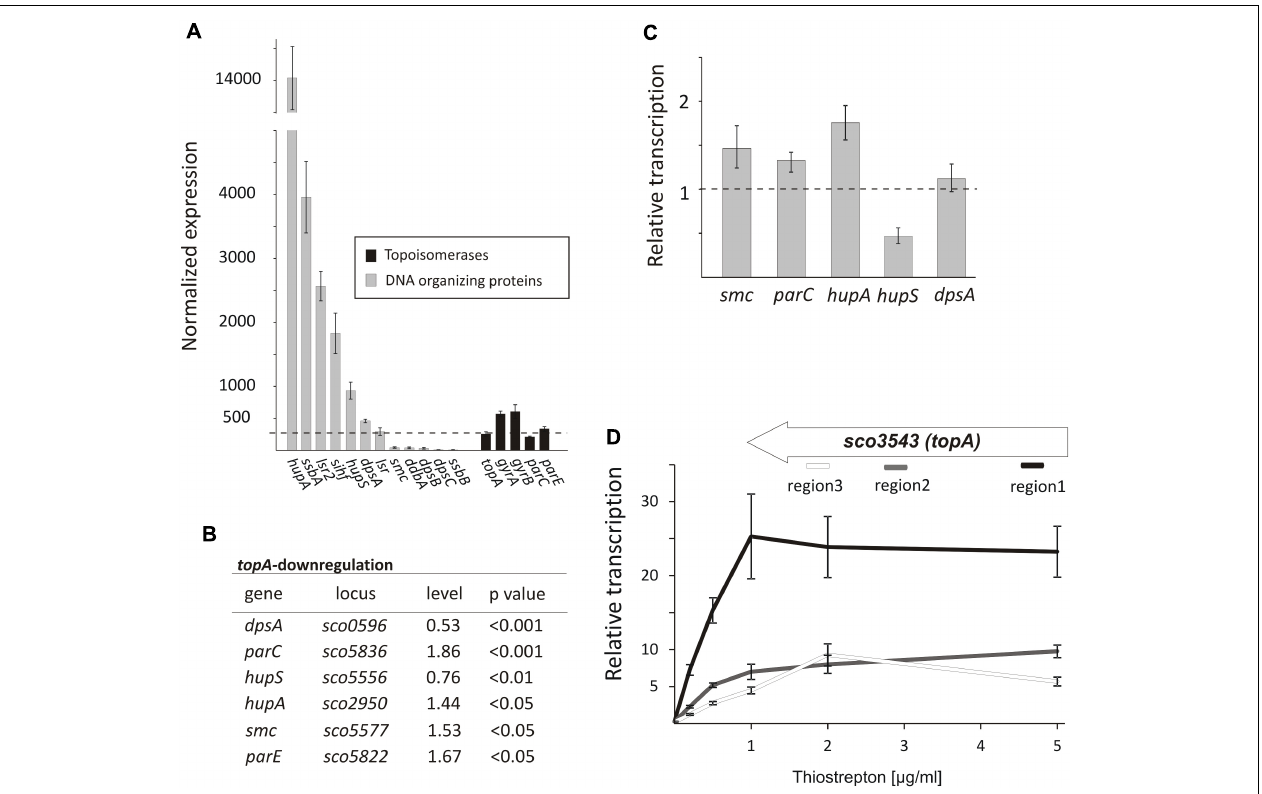
FIGURE 4 | The topological imbalance-induced transcriptional response of the genes encoding chromosome organizing proteins. (A) RNA-Seq based expression of the genes encoding DNA-organizing proteins (gray) and topoisomerases (black) in the wild type S. coelicolor strain normalized by the upper quartile. The error bars correspond to standard deviations calculated for four independent biological replicates. (B) RNA-Seq analysis of the relative transcriptional response of genes encoding DNA-organizing proteins under topA -downregulation conditions. The expression level of particular genes in the wild type strain was estimated as 1. (C) The relative transcription of selected genes in the TopA-depleted and control wild type strains calculated using RT-qPCR analysis. (D) RT-qPCR comparison of non-uniform topA gene transcription under different concentrations of topA inducer using oligonucleotide pairs specific for particular transcript regions. The transcript enrichment of particular regions was normalized by the expression of the hrdB gene which served as the endogenous control and compared to the wild type strain, in which transcription was estimated as 1. The amplified regions of the topA gene (1 – white; 2 – gray, and 3 – black) are shown